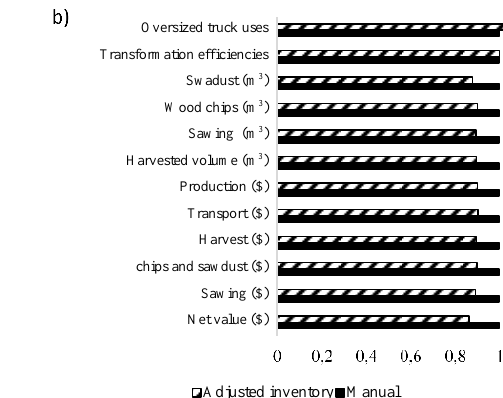
Figure 8. Impact of changing inventory data on the optimal ( a ) and manual ( b ) plans.